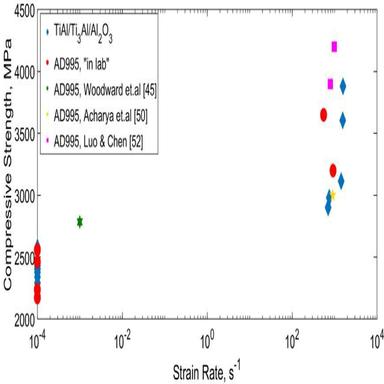
Summary of the compressive strength of the cermet with respect to strain rate under uniaxial compression with comparison to alumina AD995 manufactured by Coorstek. The alumina data was gathered from both experiments conducted in the author's lab and data reported in literature.